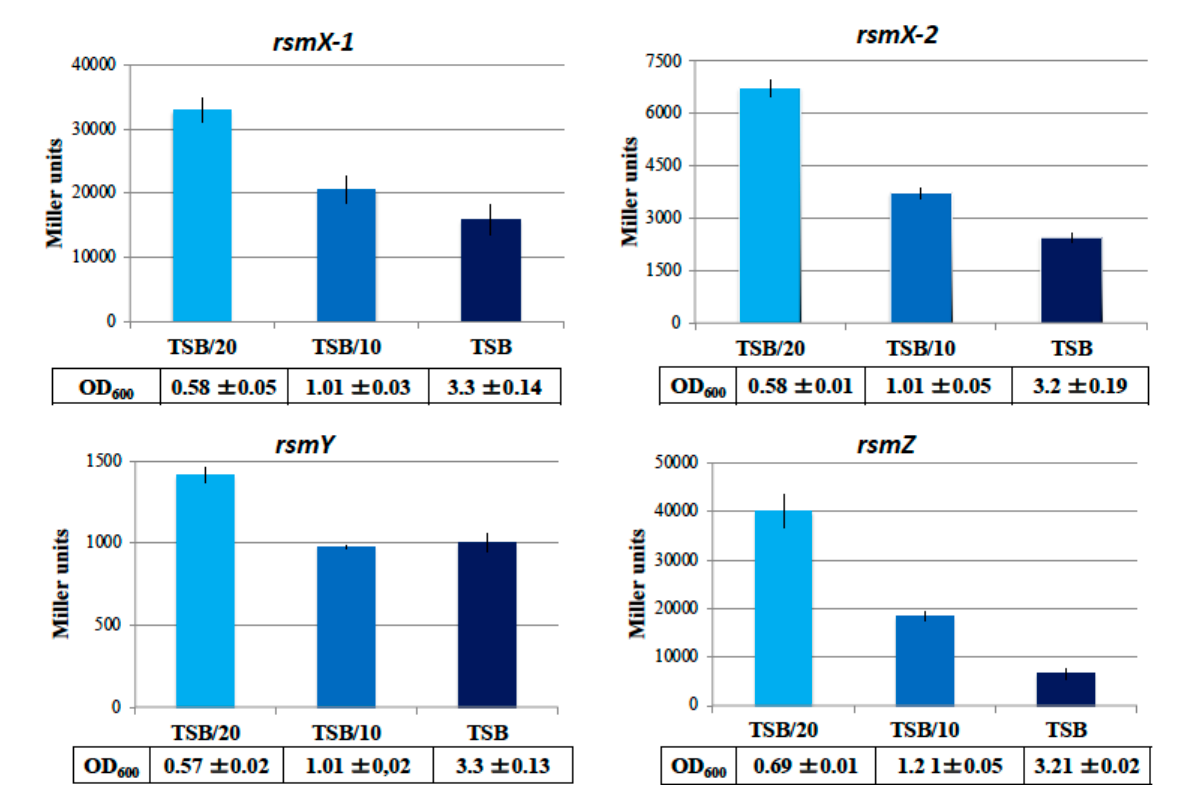
Figure 5. The expression level of rsmX-1 , rsmX-2 , rsmY and rsmZ depends on nutrient availability. Activity of a lacZ reporter fused to the promoter regions of rsmX-1 , rsmX-2 , rsmY and rsmZ were measured in the P. brassicacearum wild-type strain and are reported as Miller units of β -galactosidase activity ( ± standard deviation). The cultures were grown for 24 h at 30 ◦ C before being tested and the tables below each graph indicate the OD 600 of the cultures. Experiments were conducted in triplicates.